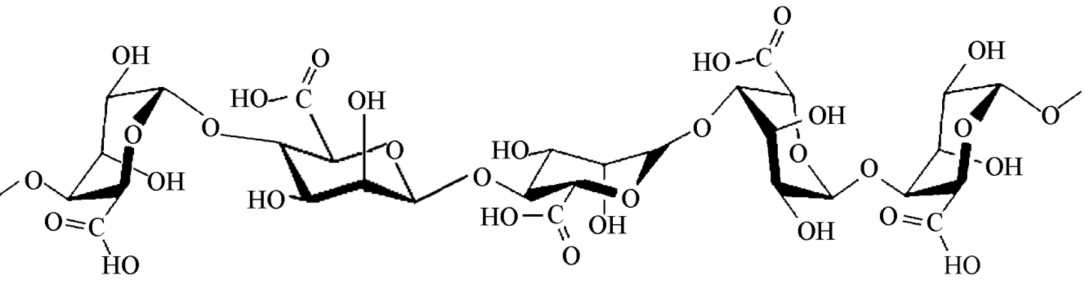
Figure 9. Schematic representation of an alginate